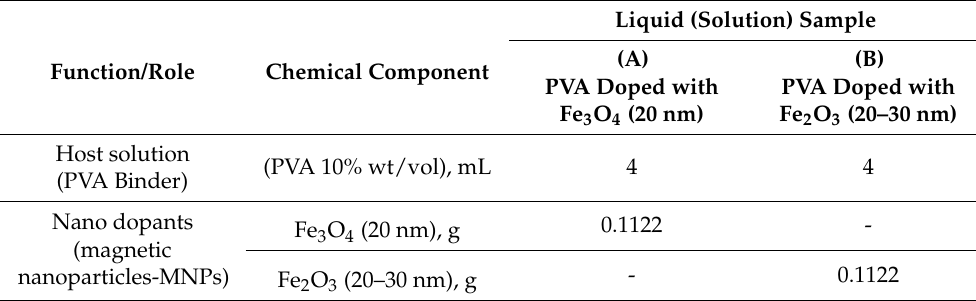
Table 1. Composition of liquid samples (A, B); they were exposed to magnetic induction under alternating magnetic